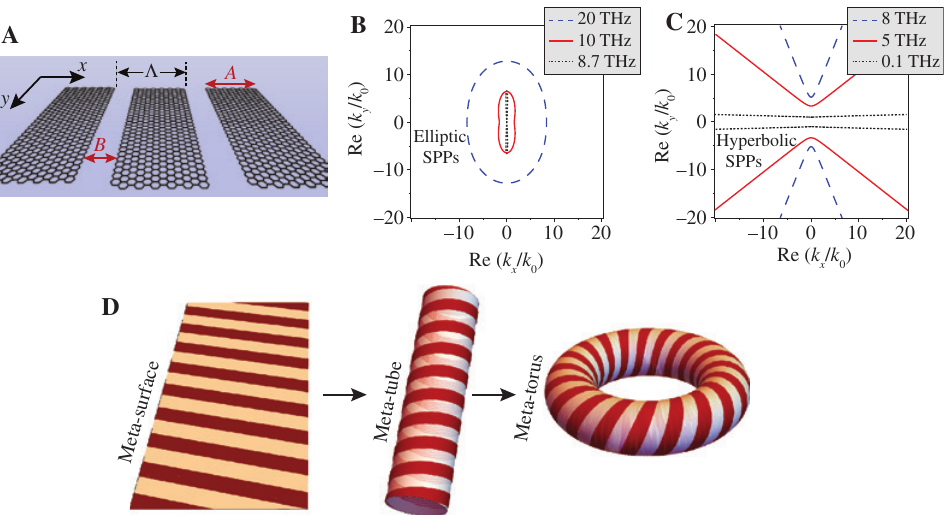
Figure 1: Plasmonic meta-surfaces and topological nanostructures. (A) An array of densely packed graphene stripes with subwavelength periodicity Λ forms a metasurface that may support both elliptic (B) and hyperbolic SPPs (C). A rolled-up meta-surface forms a meta-tube, and its donut-like shape is a meta-torus (D). In B and C, Λ = 50 nm, A = 45 nm, B = 5